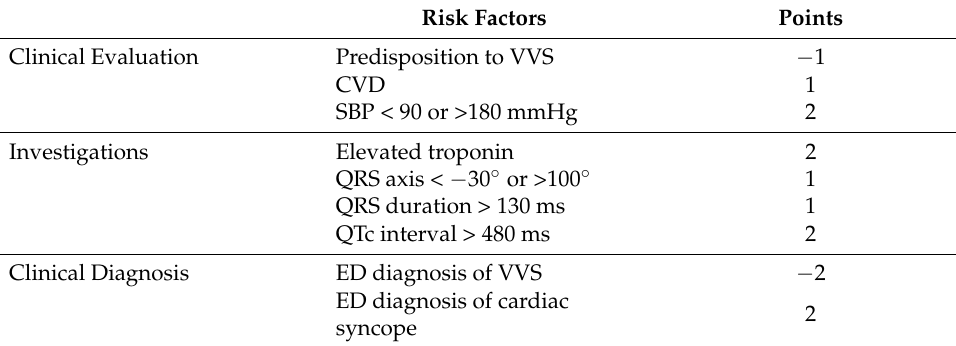
Table 4. The Canadian Syncope Risk Score [43]. Risk Factors